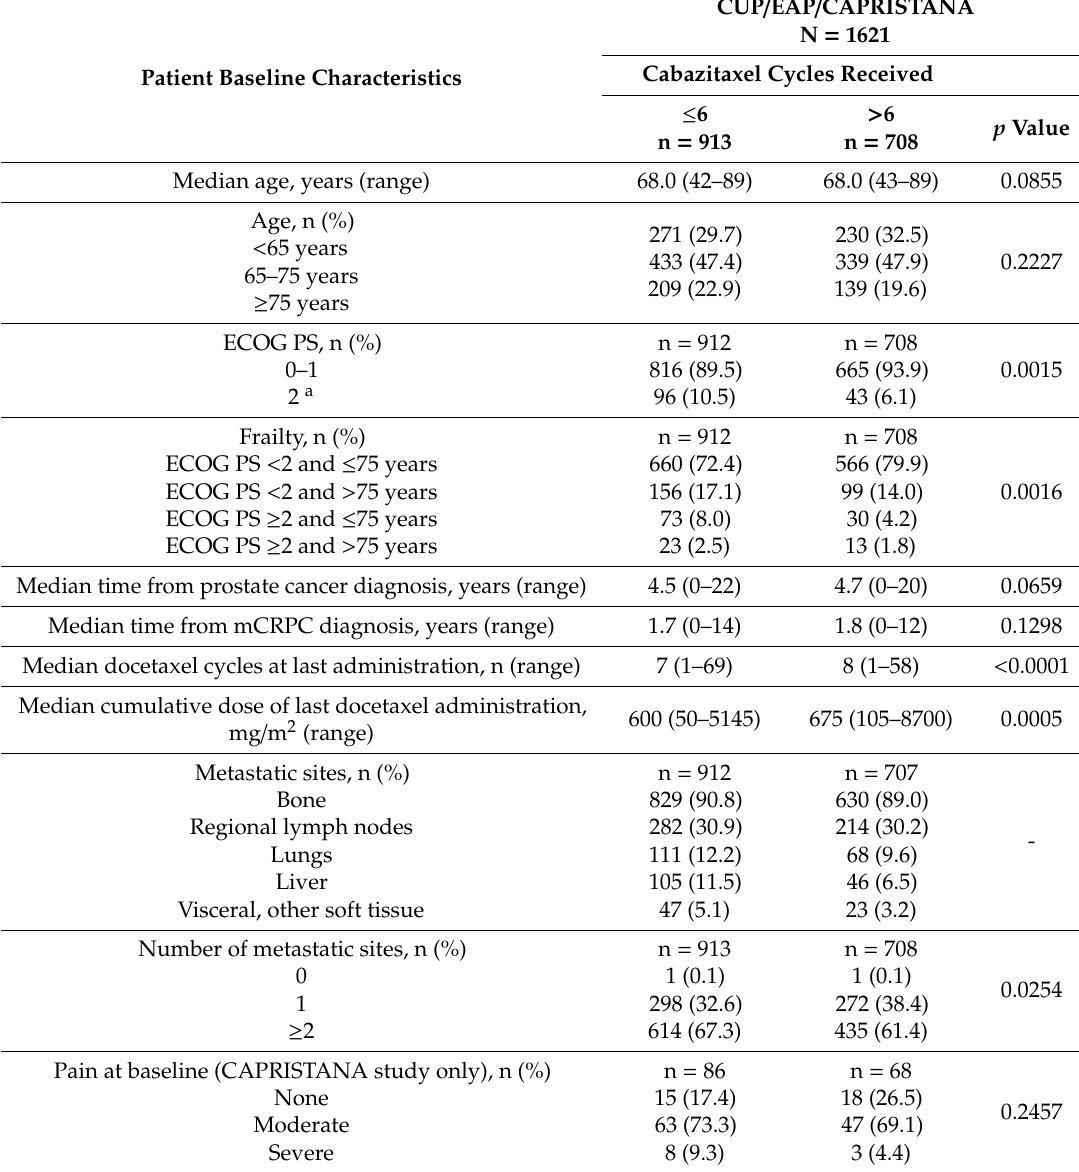
Table 2. Patient baseline characteristics according to the number of cabazitaxel treatment cycles received ( ≤ 6 vs. > 6 cycles) across the CUP / EAP and CAPRISTANA